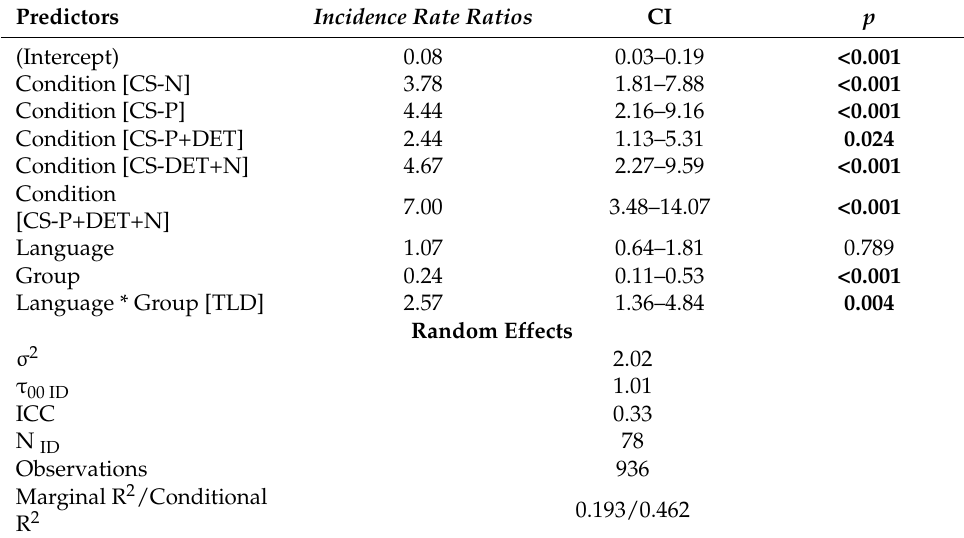
Table 3. Estimates of the model predicting the frequency of non-targeted